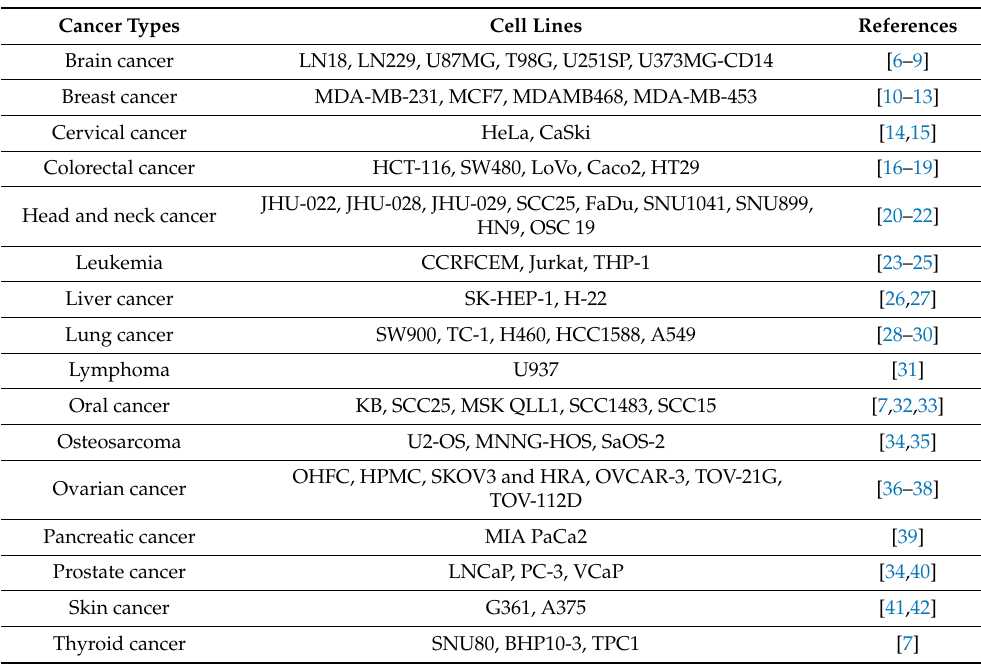
Table 1. Cancer cell lines shown to be responsive to cold atmospheric plasma in